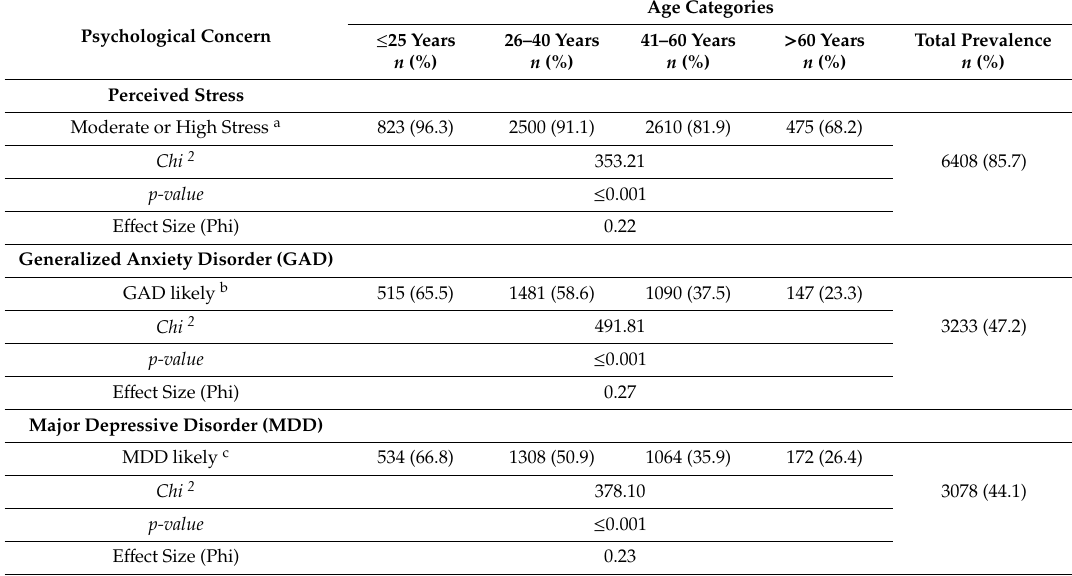
Table 2. Chi-Square test of association between age categories and the prevalence of perceived stress, likely generalized anxiety disorder, and likely major depressive